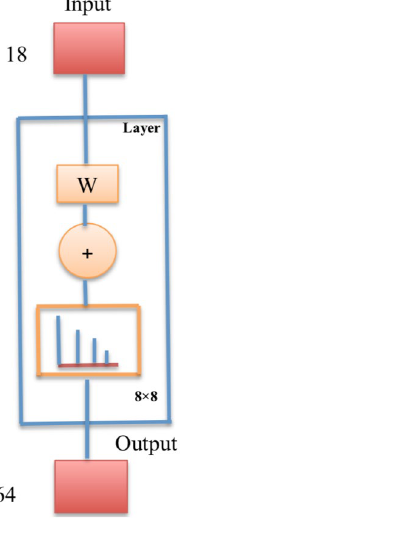
Figure 2. Training